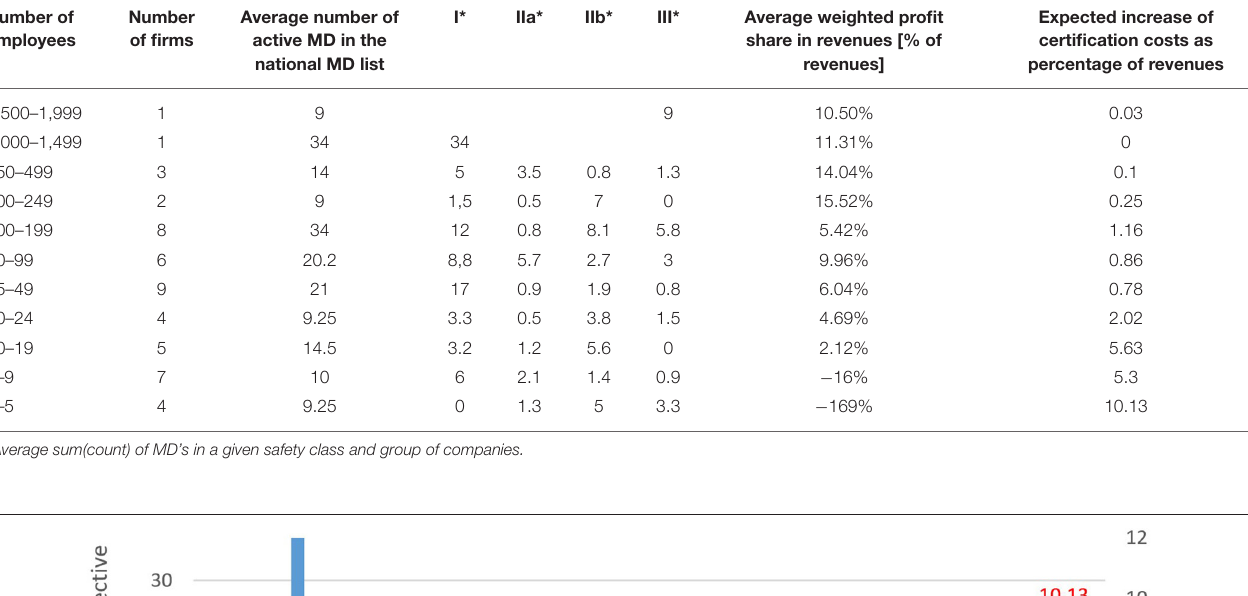
TABLE 4 | Medical device market in the Czech Republic – MD type, production, economic indicators. Number of employees